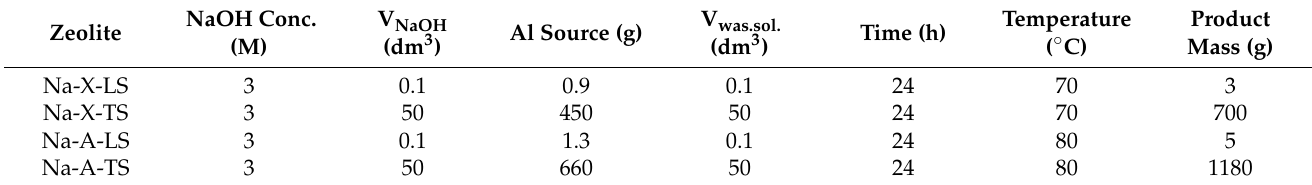
Table 1. Synthesis conditions of studied